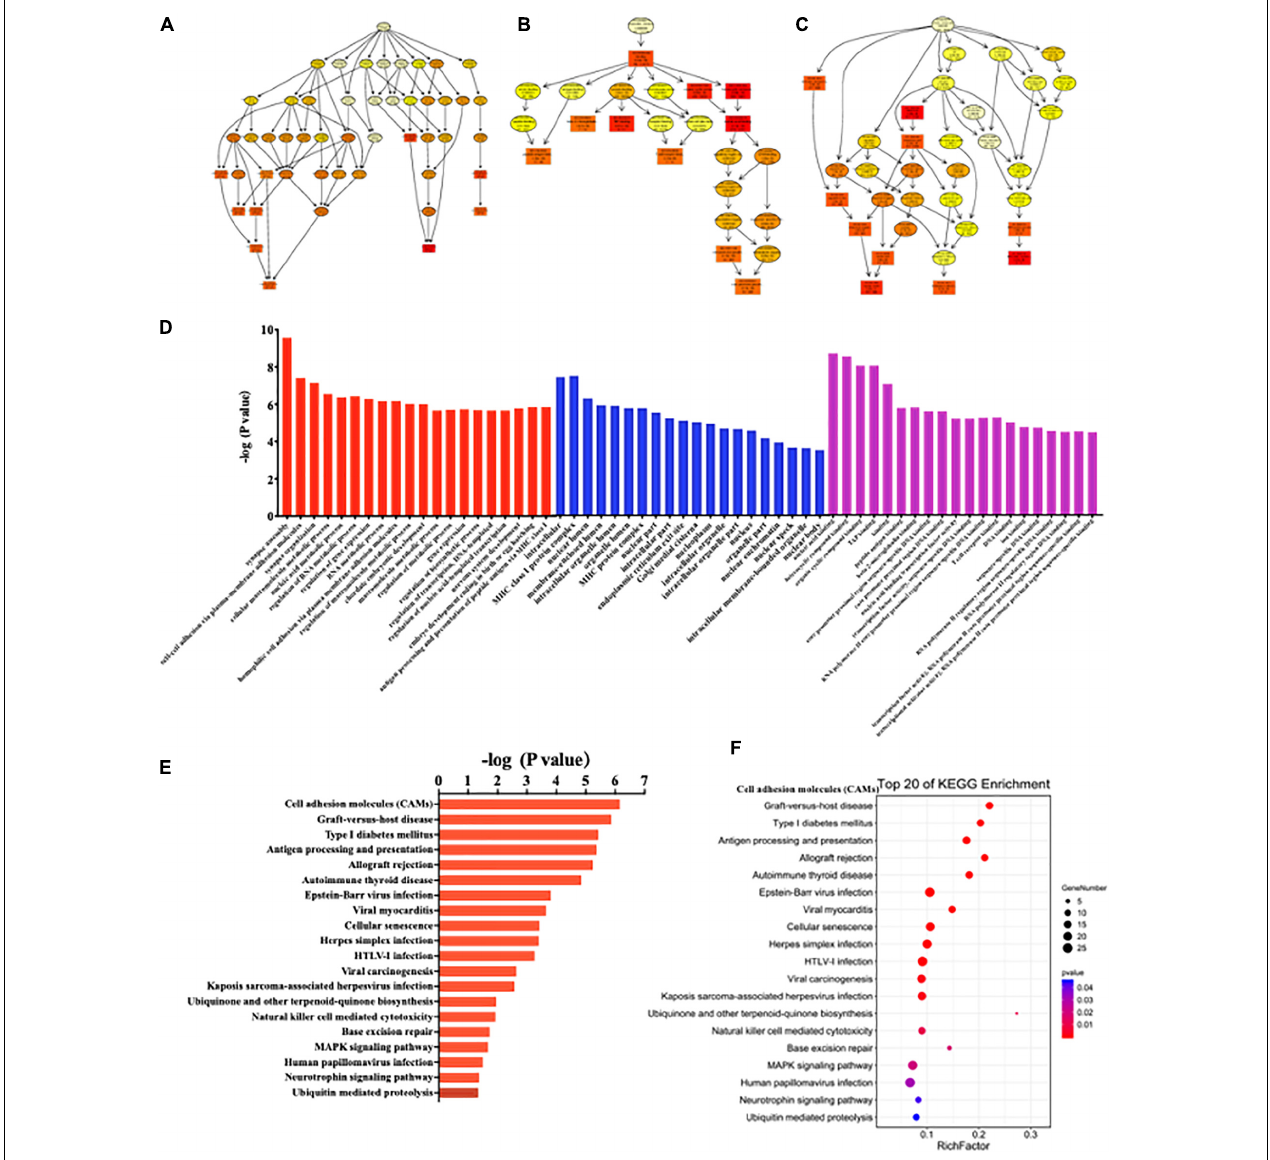
FIGURE 9 | Functional prediction of DE lncRNAs by GO and KEGG analyses in the spinal cord of SNL mice. (A–C) Directed acyclic graphs (DAGs) graphically display the significant GO enrichment results with the candidate targeted genes in biological process (A) , molecular function (B) , and cellular component (C) . (D) Significant molecular function, biological process, and cellular component enrichment analysis of DE lncRNA-related mRNAs. The enrichment scores ( − log10 ( P -value)) of the GO term were shown in the histogram. (E,F) The DE lncRNA-related mRNA-enriched KEGG pathways represented by enrichment scores ( − log10 ( P -value)) (E) and the scatterplot showing statistics of pathway enrichment (F) , respectively. The color of pathway terms is defined by the enrichment P -value.